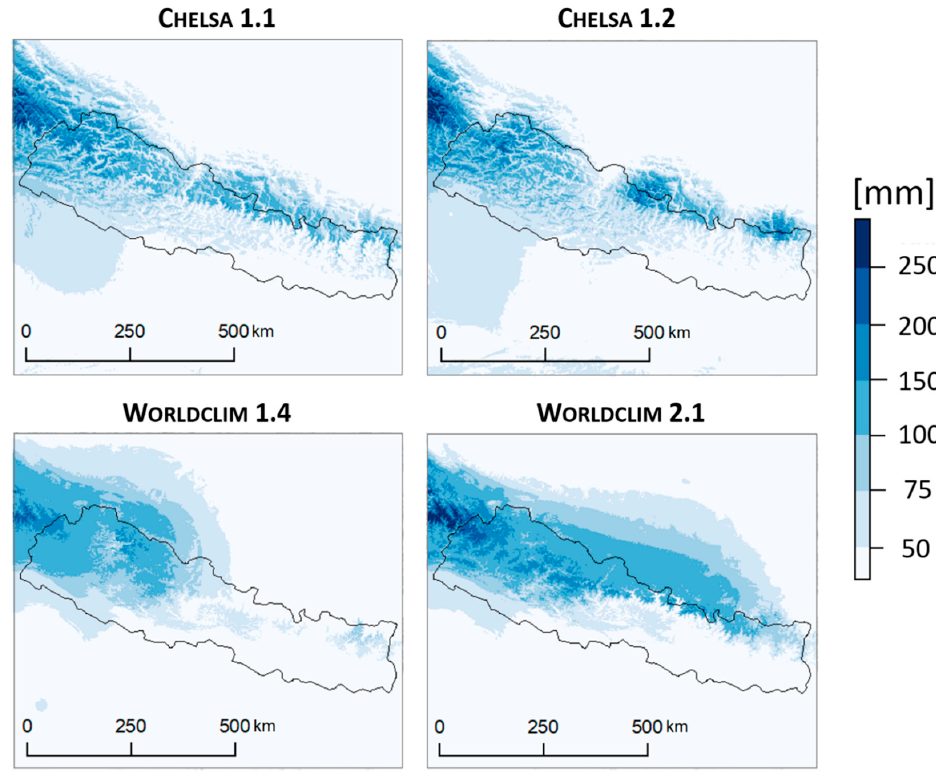
Figure 3. Precipitation of the Coldest Quarter for all climate datasets and respective versions. Table 3. Spearman rank correlation coefficients of Mean Temperature of the Wettest Quarter for all climate datasets and respective versions. All correlations were highly significant ( p ≤ 0.001).